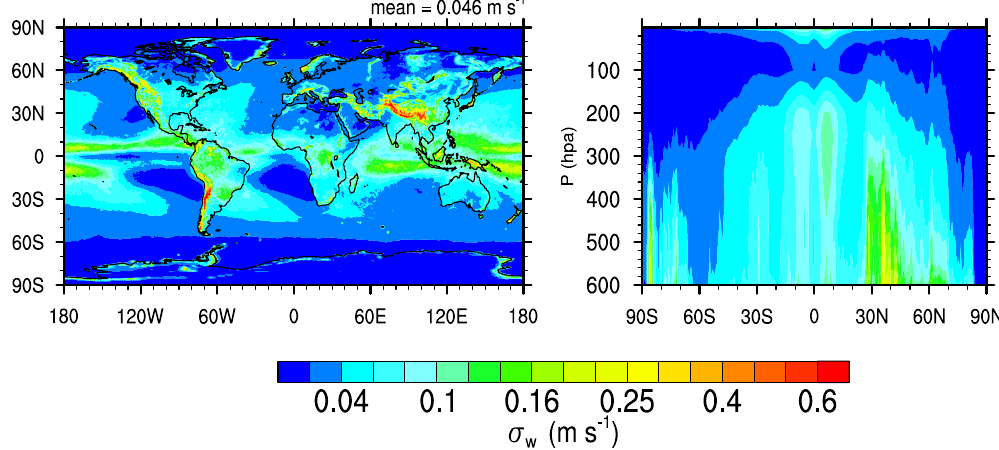
Figure 4. Annual mean standard deviation in vertical velocity (m s − 1 ) at a horizontal resolution of 1°, calculated from 7 km global output. Left panel: σ w at 250 hPa. Right panel: zonal mean σ w . Maps generated using the NCAR Command Language (Version 6.3.0) Software. (2016). Boulder, Colorado: UCAR/NCAR/CISL/ TDD. http://dx.doi.org/10.5065/D6WD3XH5.